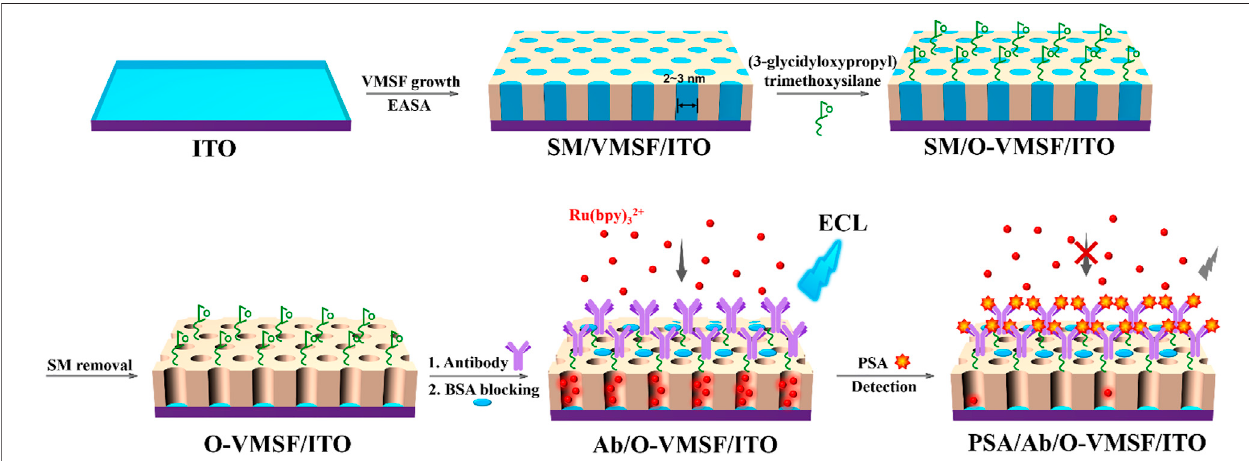
FIGURE 1 | Schematic illustration for the fabrication of the immunosensing interface on the VMSF-modi fi ed electrode and the following label-free ECL detection of PSA.